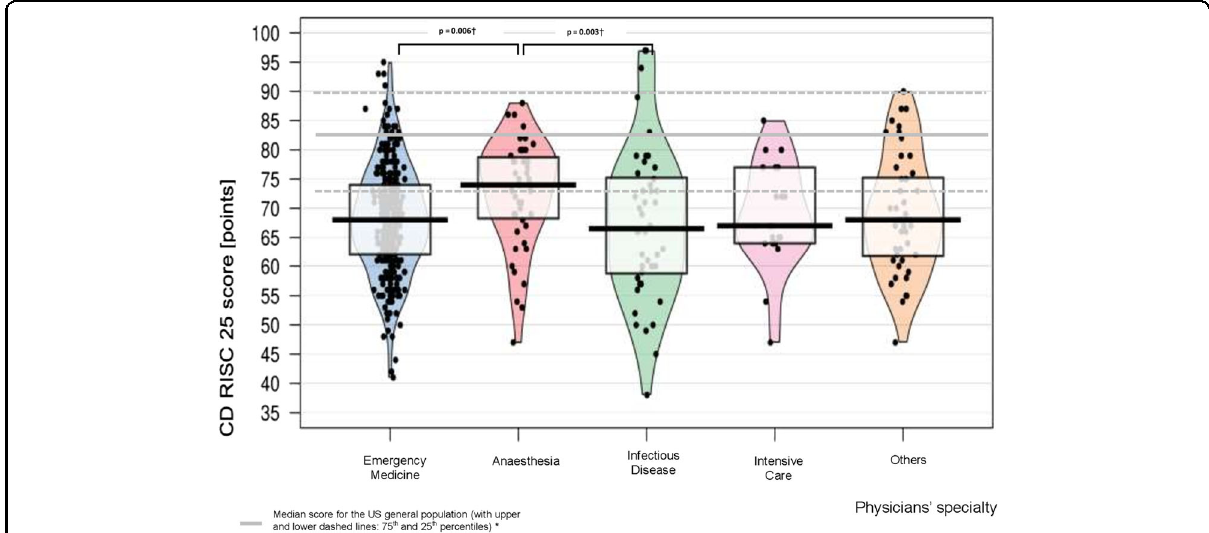
Fig. 1 Violin plots according to the resilience ’ s scores and the kind of specialty. Resilience was assessed using the CD-RISC 25 scale [0 – 100]. In the box plots, the boundary of the box closest to zero indicates the 25th percentile, a black line within the box marks the median, and the boundary of the box farthest from zero indicates the 75th percentile. *Median in the US general population in the original description of the CD-RISC25 = 83 (73 – 90). † Global comparison was performed using Kruskall – Wallis test ( p = 0.02) and post-hoc test using Dunn test with a Hochberg multiple comparison procedure, p signi fi cant.